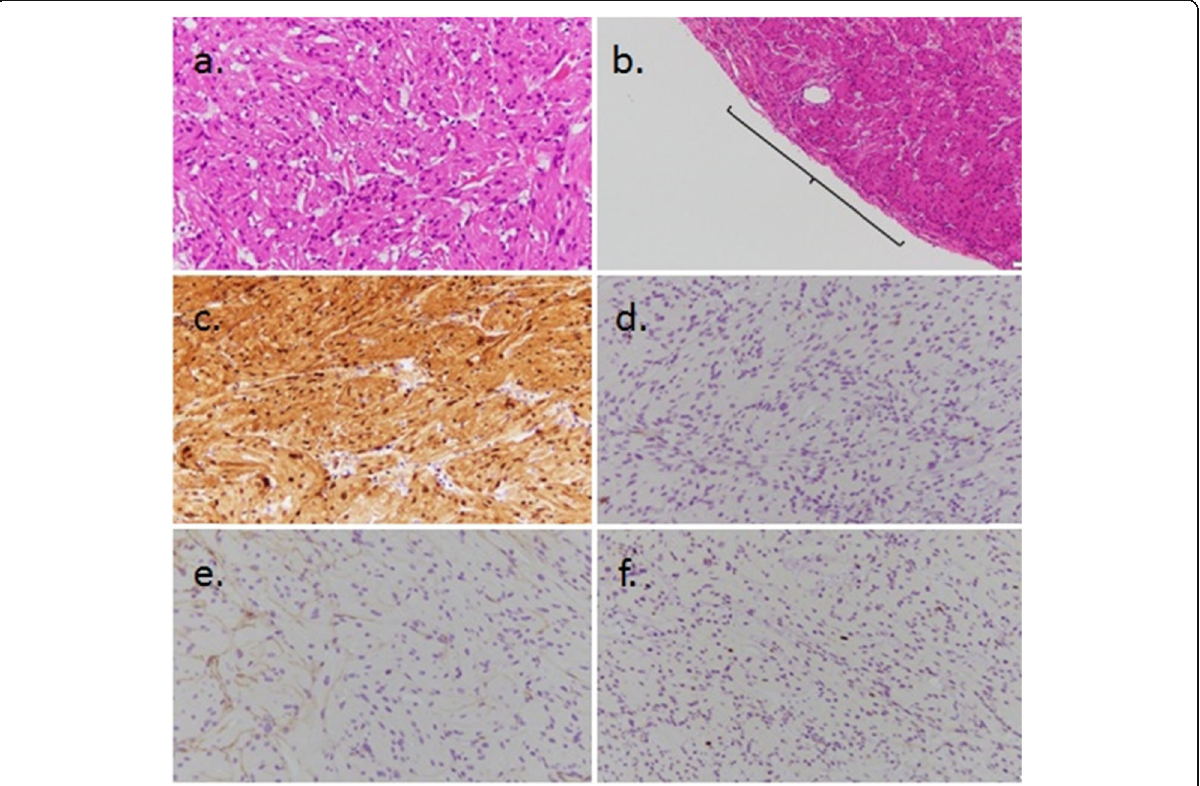
Fig. 4 a The specimens of surgically resected tumor using hematoxylin-eosin staining (× 400). b The capsule of the tumor was partially lacking using hematoxylin-eosin staining (× 100). c The specimens of surgically resected tumor using immunohistochemical staining for S-100 protein (× 400). d The specimens using immunohistochemical staining for c-kit (× 400). e The specimens using immunohistochemical staining for CD34 (× 400). f The specimens using immunohistochemical staining for Ki-67 (×